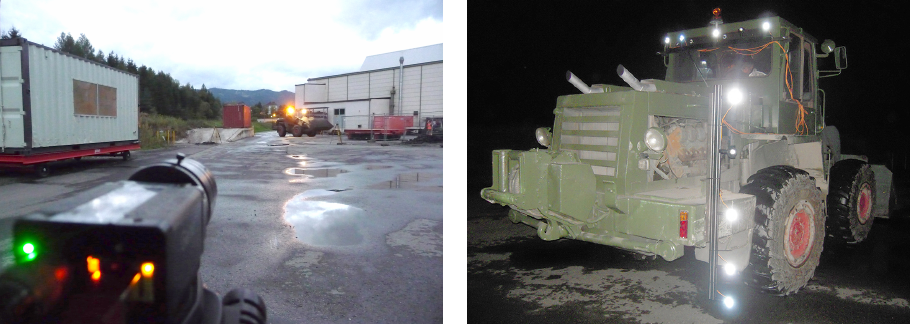
Figure 30. Details of the test